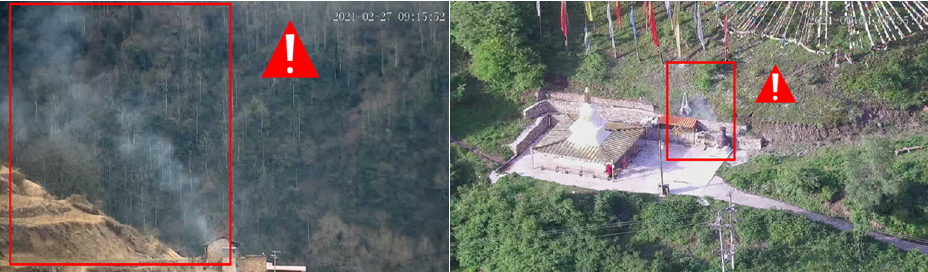
Figure 1. Non-hazardous smoke in a forest monitoring scenario causing an alarm when using existing smoke detection methods.